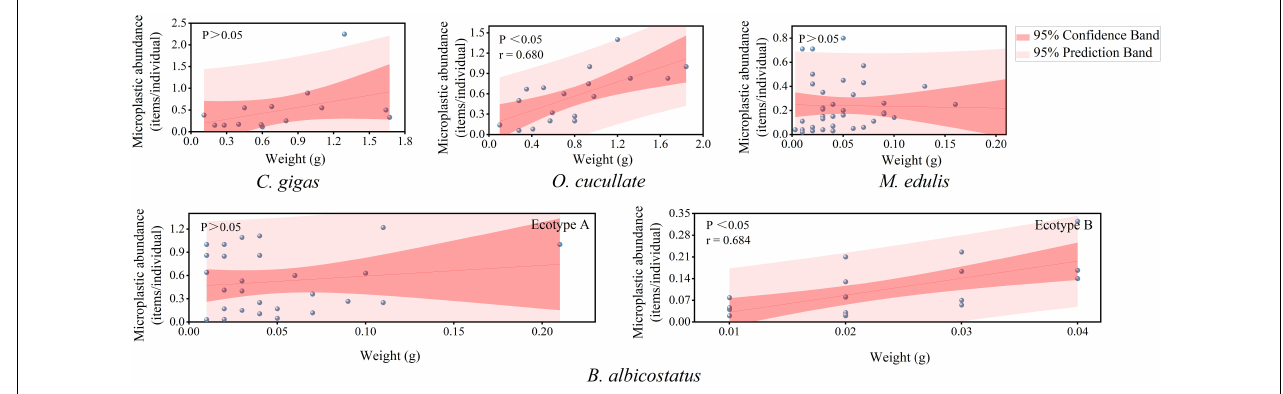
FIGURE 9 | Correlation analysis between MP abundance and wet weight of the total tissues of barnacles and wild bivalves. The red line is the fitted trend line, gray ball represents the abundance value of MPs in different weights of organisms. intertidal zone of the Yellow Sea has been contaminated by MPs (Teng et al., 2019; Feng et al., 2020c). Therefore, barnacles and wild bivalves can be exposed to MPs in natural